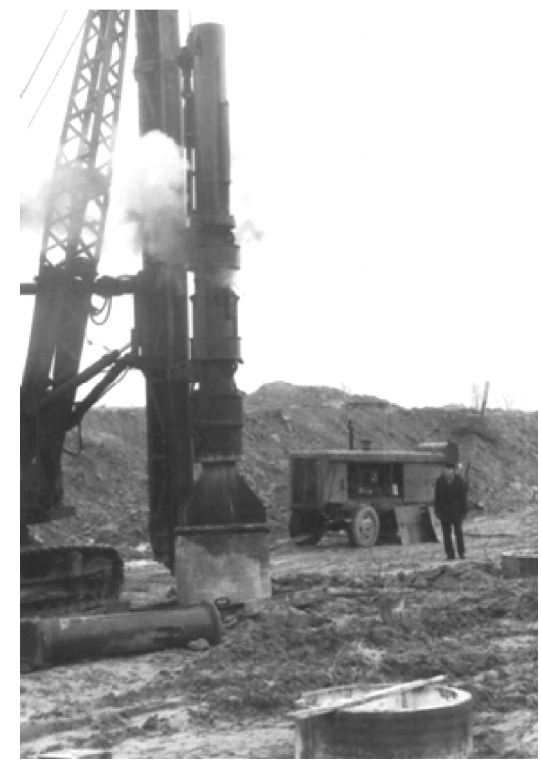
Fig. 4. Driving the ring with the use of the